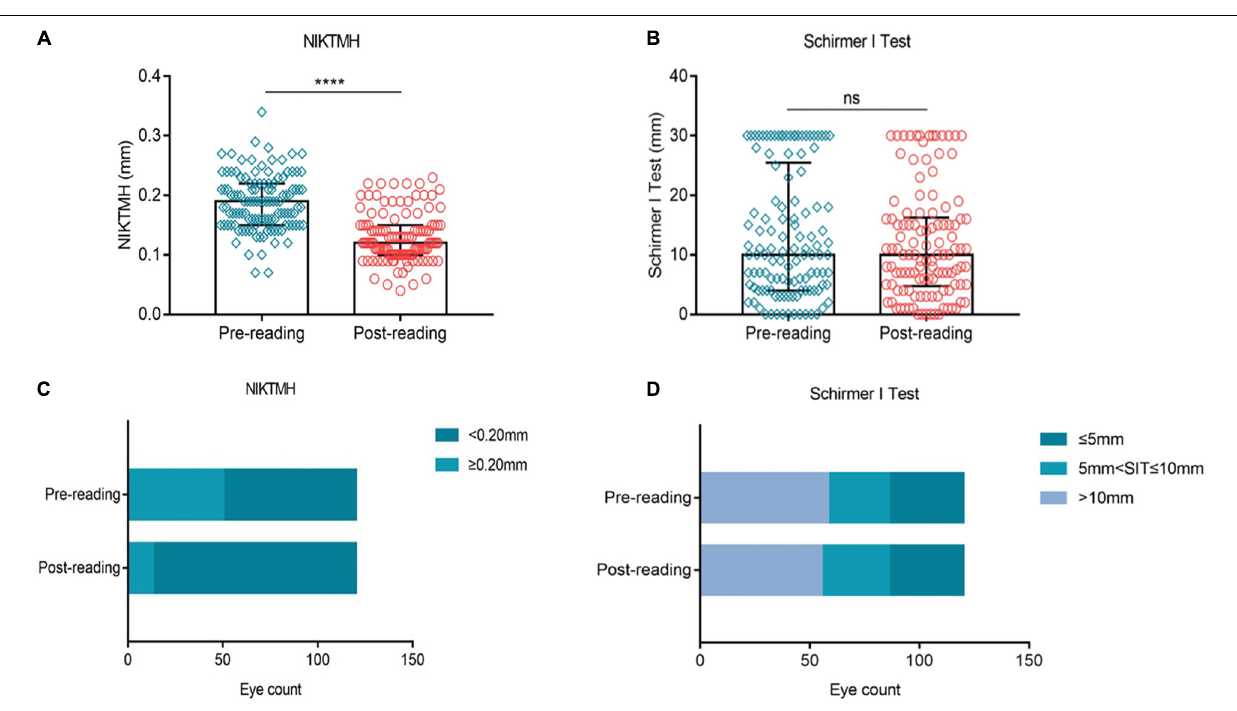
FIGURE 4 | Effects of continuous smartphones reading for 2 h on tear volume. Compared to the baseline level, NIKTMH (A) decreased significantly, while the proportion of NIKTMH < 0.20 mm increased significantly (C) . The Schirmer I test (B) and the proportion of the Schirmer I test ≤ 5 mm (D) did not change significantly between the two groups. (A–B) Dates are presented as median and interquartile range, **** p ≤